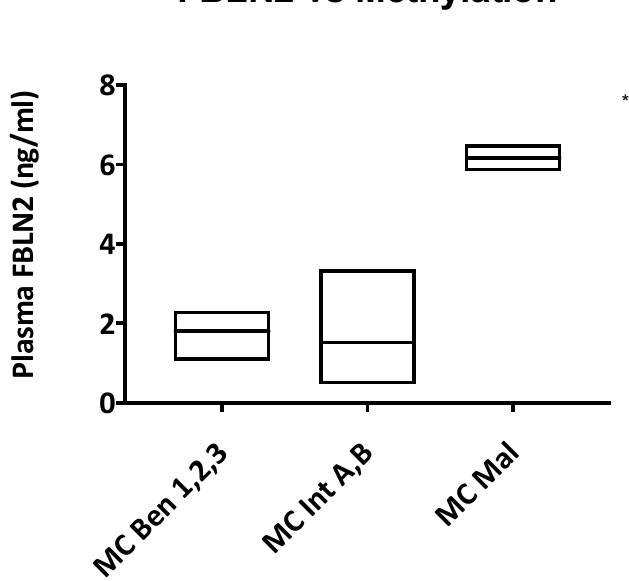
Table 1. Clinical characteristics of the meningioma samples used ( n = 178). There were two grade I meningioma patients with mixed histology; one had metaplastic, transitional and microcystic (sphenoid wing) and transitional (frontal) tumours; the other had a mixed meningothelial, micro- cystic and angiomatous meningioma. Figure 4. Plasma Fibulin-2 levels correlate with methylation class aggressiveness. The figure shows the relationship between methylation class and Fibulin-2 levels, irrespective of meningioma grade. MC = methylation class; Ben 1,2,3 = benign classes, Int A,B = intermediate classes, Mal = malignant class. ANOVA *** p < 0.0001.